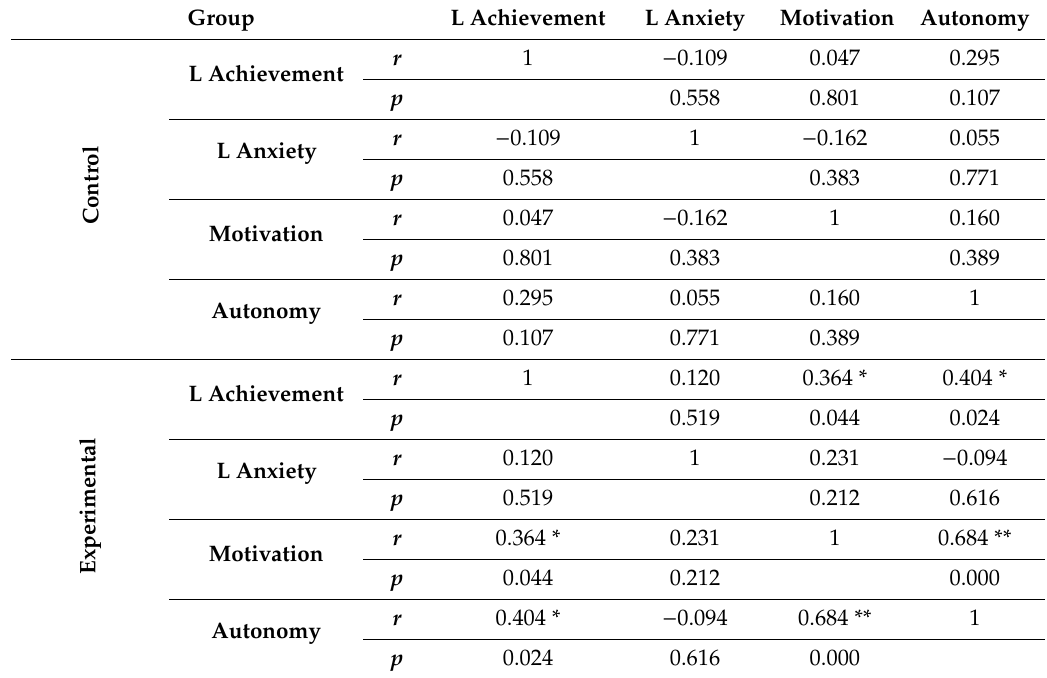
Table 4. Correlation between dimensions for each